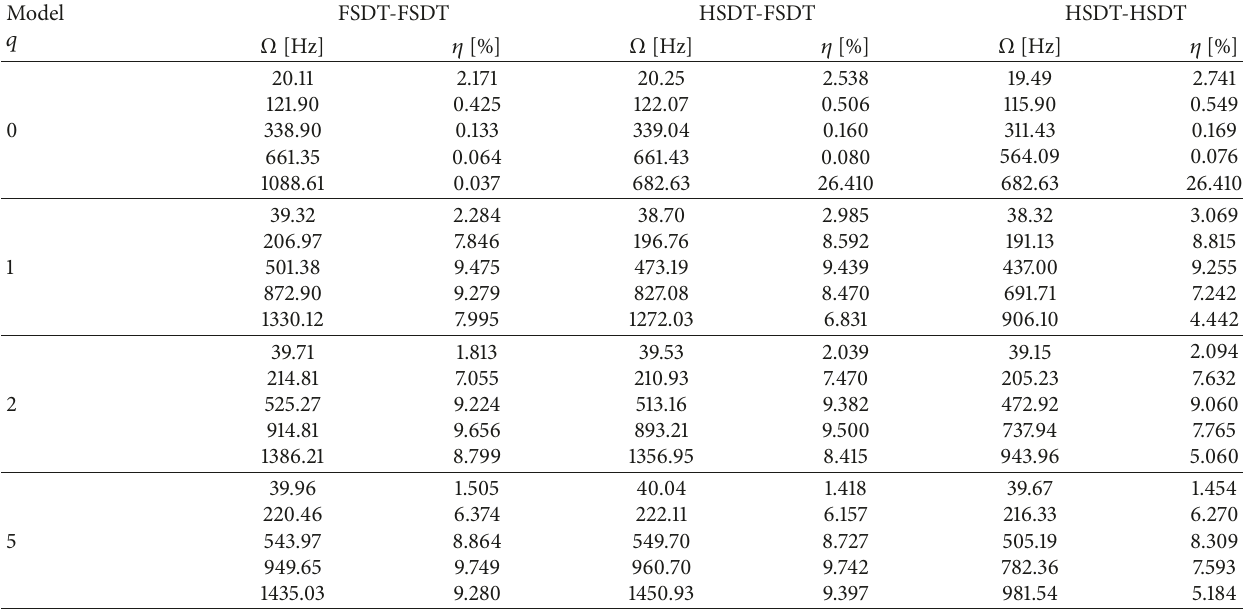
Table 16: Frequencies Ω and loss factors 𝜂 . 𝑤 max GNP = 5 %. Core ( 𝐶3 – 𝐶1 ). Mg, 𝑝 = 0